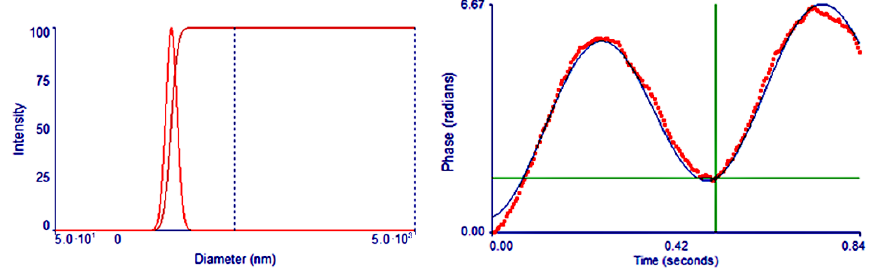
Figure 10. Zeta potential and size distribution of N-2-HACC NPs.